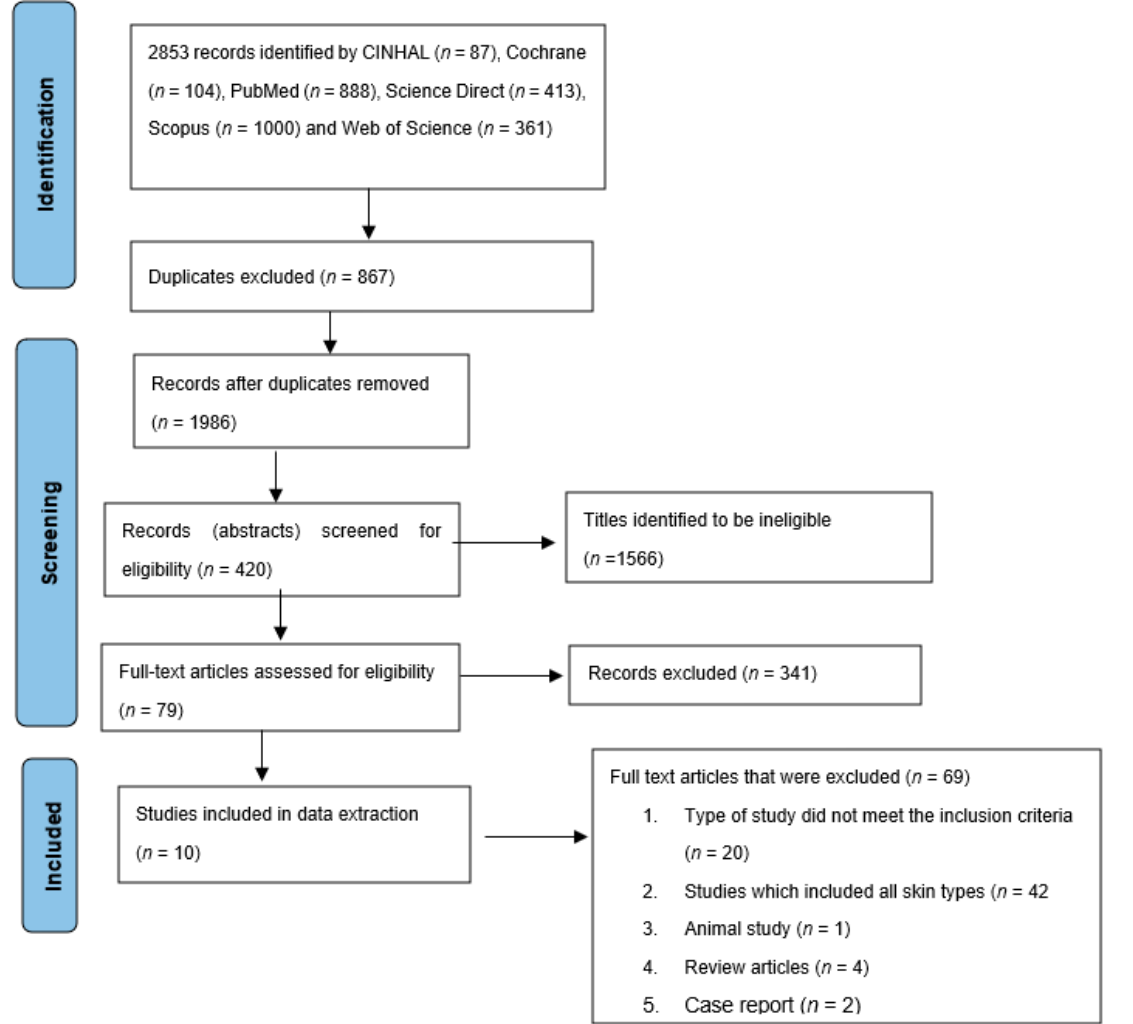
Figure 1. Flow diagram demonstrating the literature search and study selection. There was 96.2% agreement versus 50.0% expected by chance, which, according to